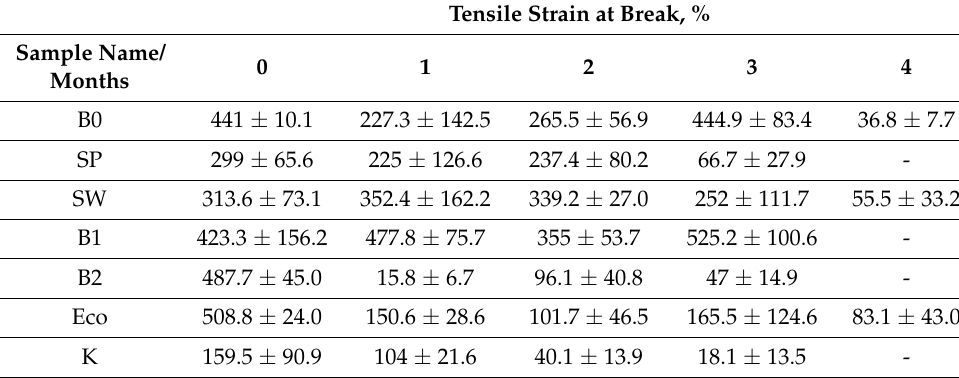
Table 4. Tensile strain at break.